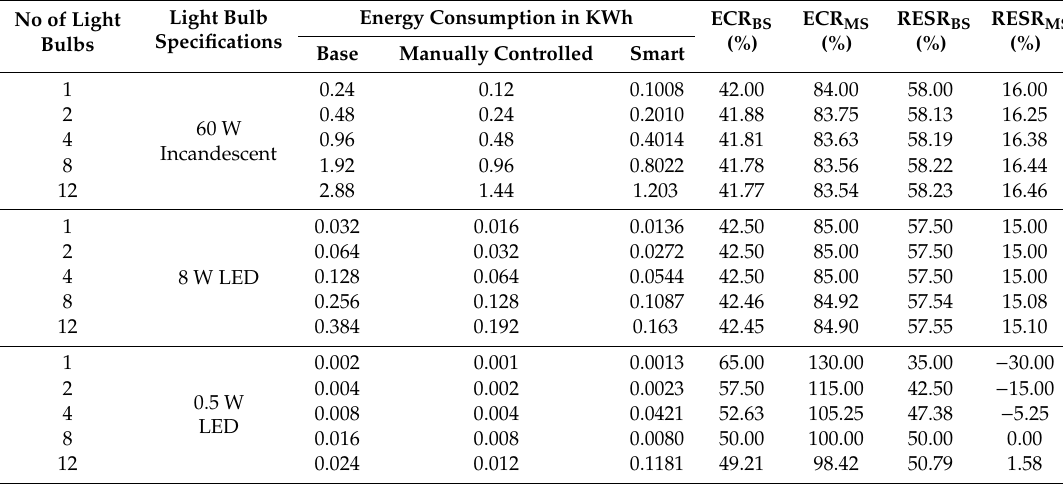
Table 11. Energy Saving